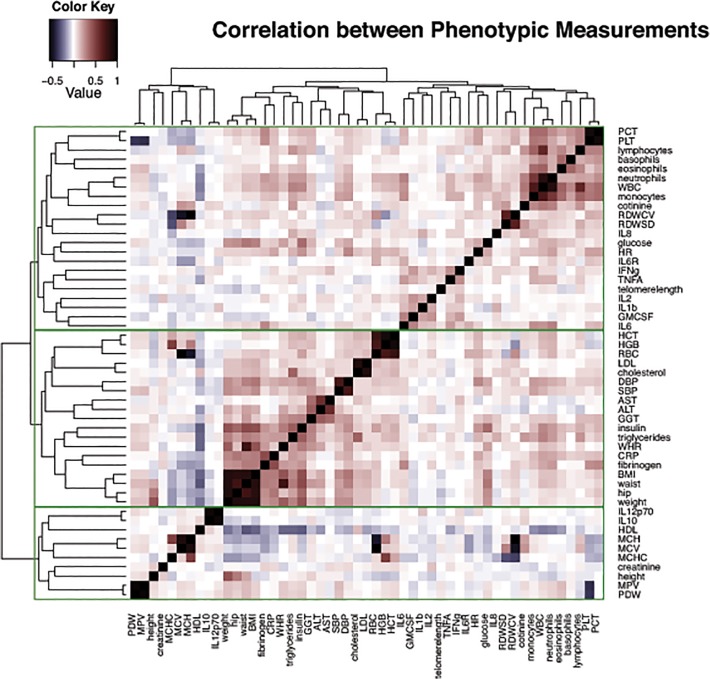
Hierarchical clustering of phenotypic measurements.This figure shows the clustering of the phenotypic measurements based on their correlations with each other. Correlations between all pairs of phenotypes are computed, while partialling out the effect related to family membership. Positive correlations are shown in red, negative correlations in purple. The clusters are shown in green.